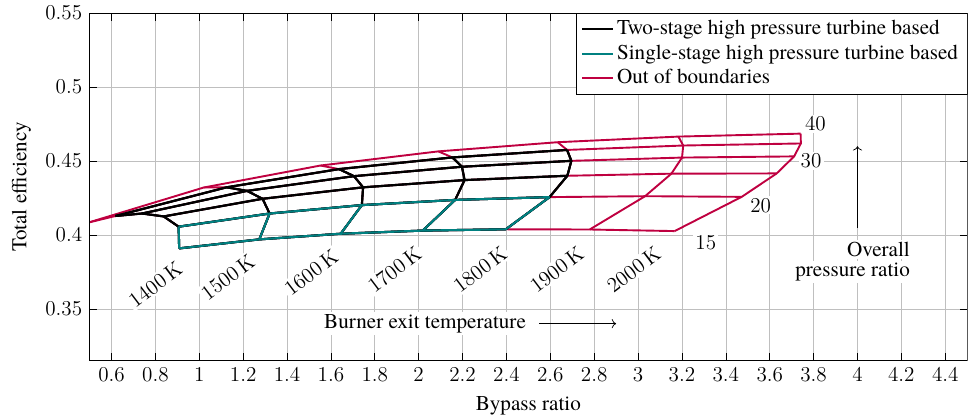
Figure 8. Detailed view of the cycle design space for Π Fan,outer = 1.6 2